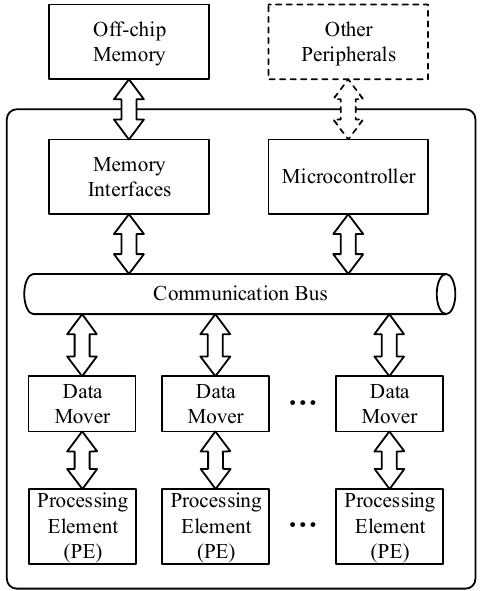
Figure 1. System Block Diagram.